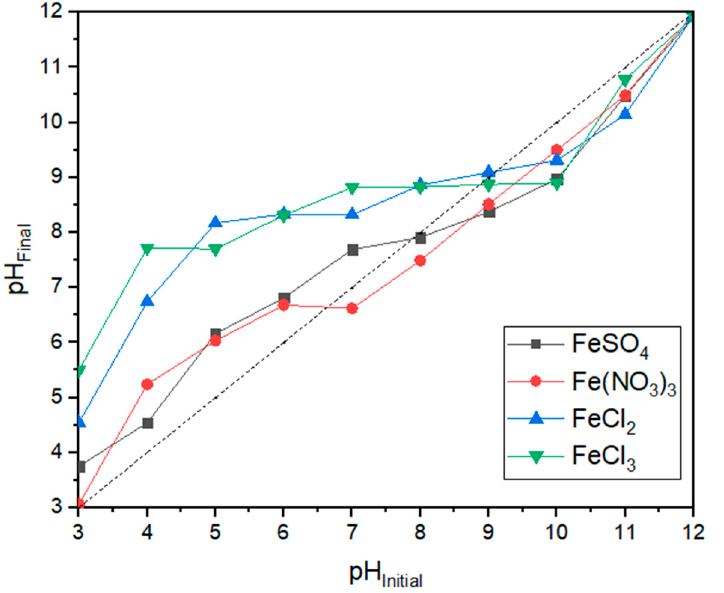
Figure 8. pH final versus pH initial during equilibration of nZVI powders in 0.1 M KNO 3 solution.